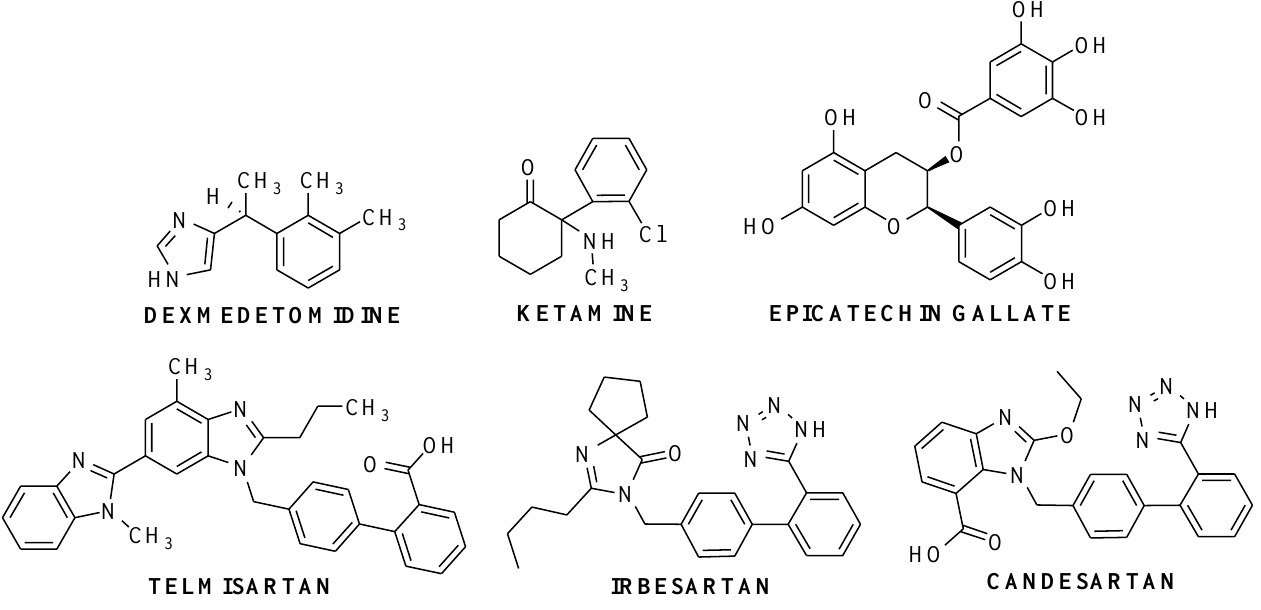
Figure 4. Molecules for the treatment of various inflammatory diseases acting via the HMGB1/RAGE